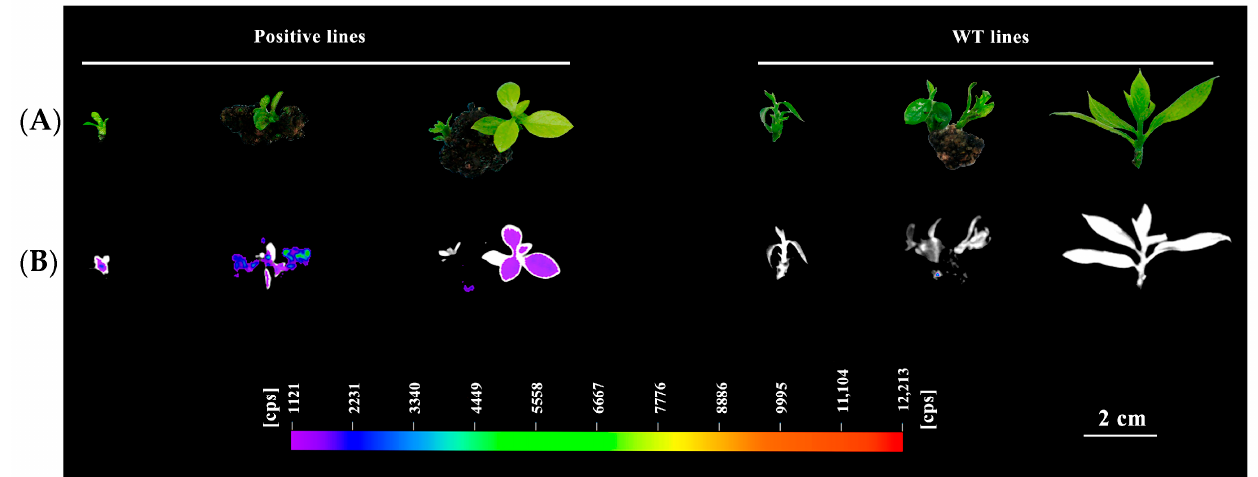
Figure 2. In vitro propagation of ‘Gongcheng Shuishi’ persimmon leaves. ( A ) Callus induction (20 days) and adventitious bud regeneration (1–2 months) of ‘Gongcheng Shuishi’ in different media.